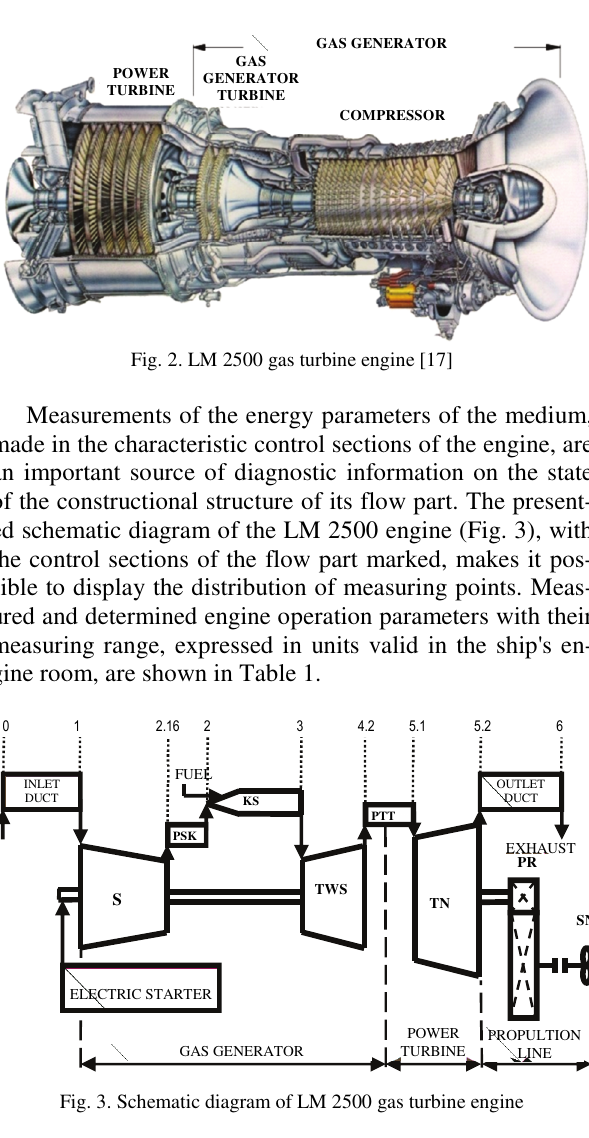
Fig. 4. The air intake system and the exhaust system of the LM 2500 engine installed on the missile frigate with marked sampling point and the